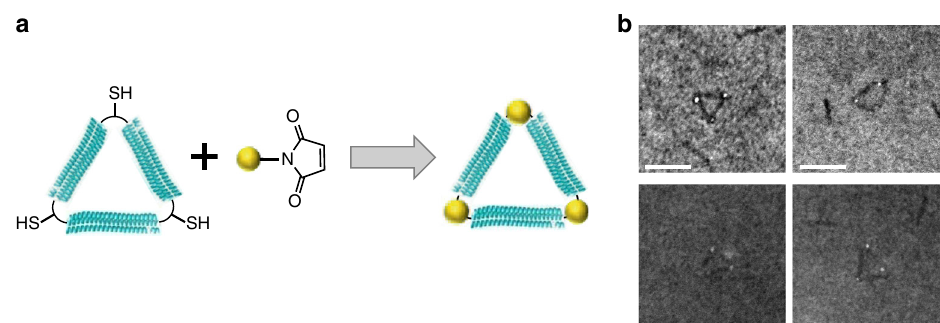
Fig. 5 Assembly of gold nanoparticles (AuNPs) using Tri10t as a molecular scaffold. a Schematic depicting the conjugation of AuNPs to the vertices of the Tri10t protein nanostructures. b Dark- fi eld STEM images showing AuNPs (lighter than background) attached to the three vertices of the protein nanostructures (darker than background). Scale bars,